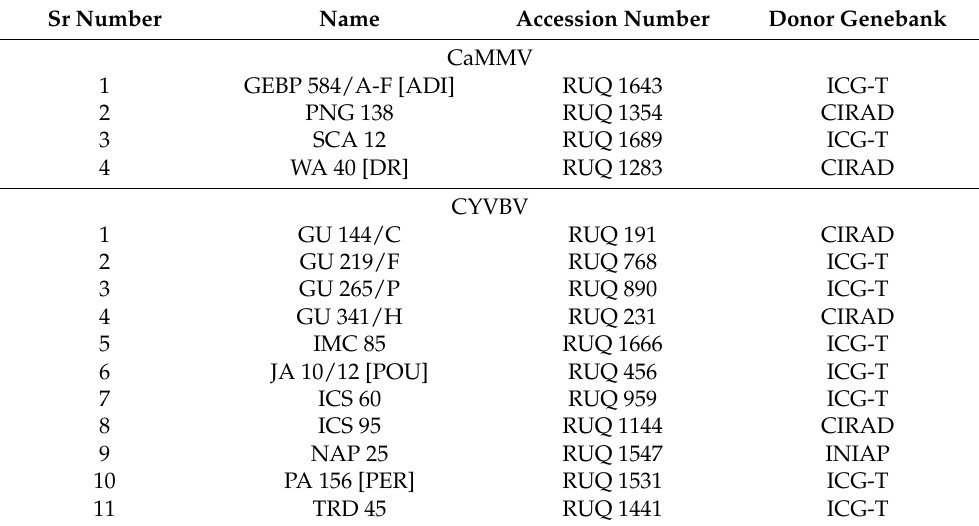
Table 1. Summary of germplasm in the International Cocoa Quarantine Centre, Reading, United Kingdom that tested positive for cacao mild mosaic virus (CaMMV) or cacao yellow vein-banding virus (CYVBV). A total of 352 accessions were